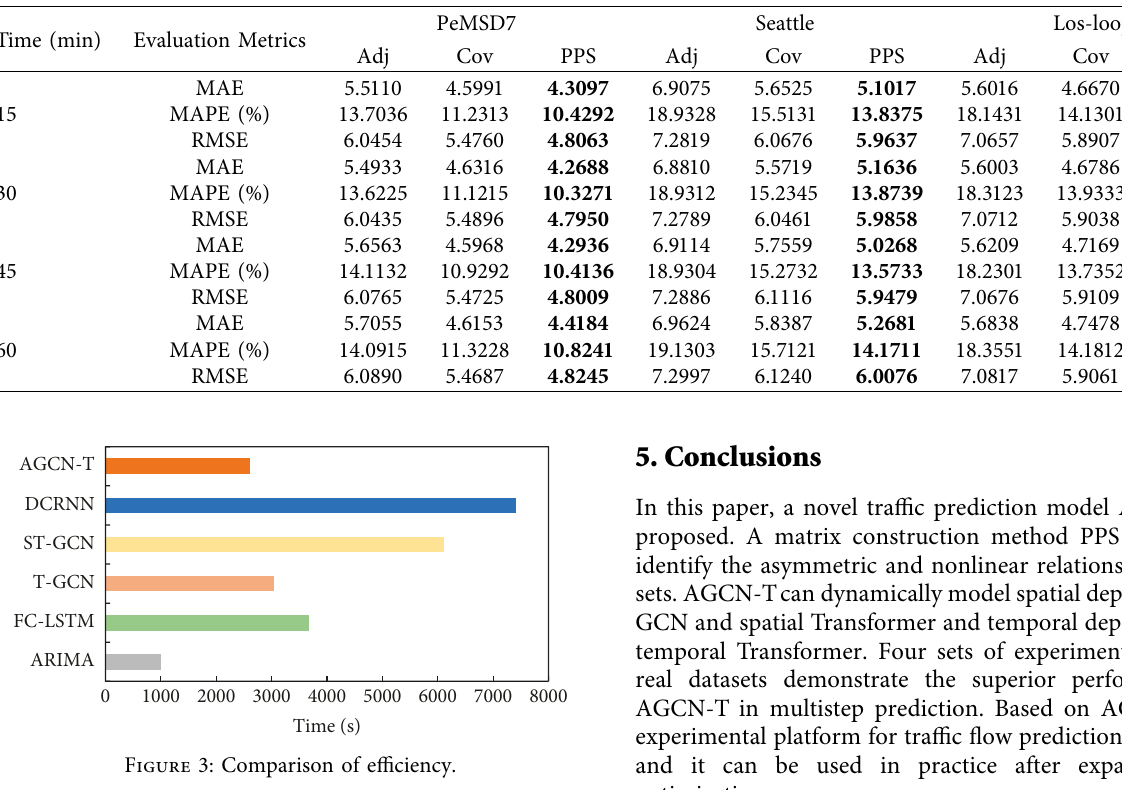
Table 9: Effect of PPS.